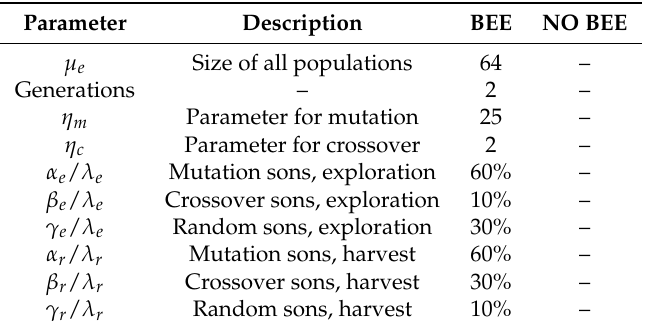
Table 1. Summary of the configuration parameters used in the